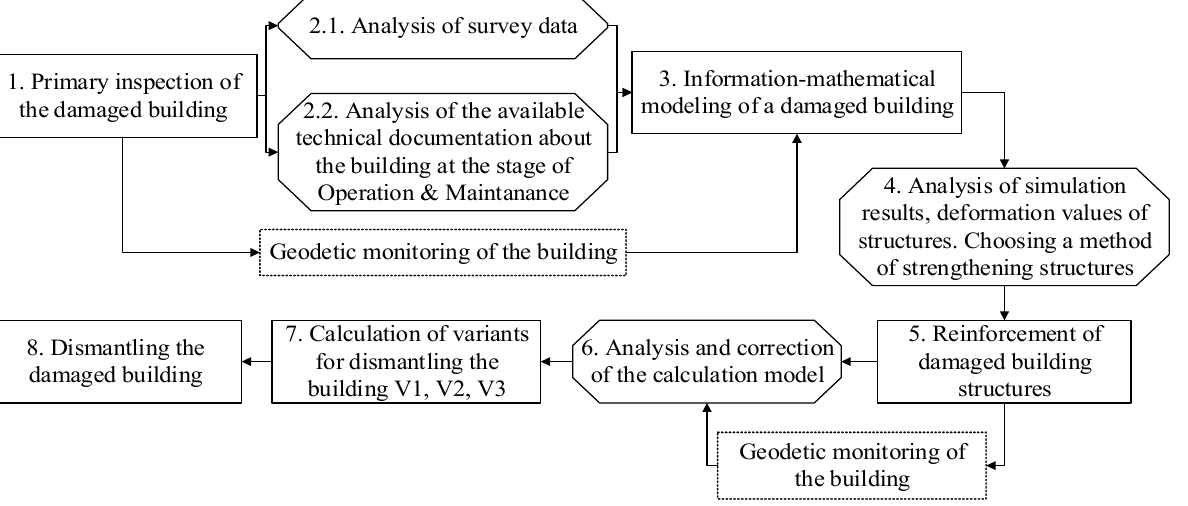
Figure 7. Workflow of the large-panel building damage assessment and decision-making for the case study.